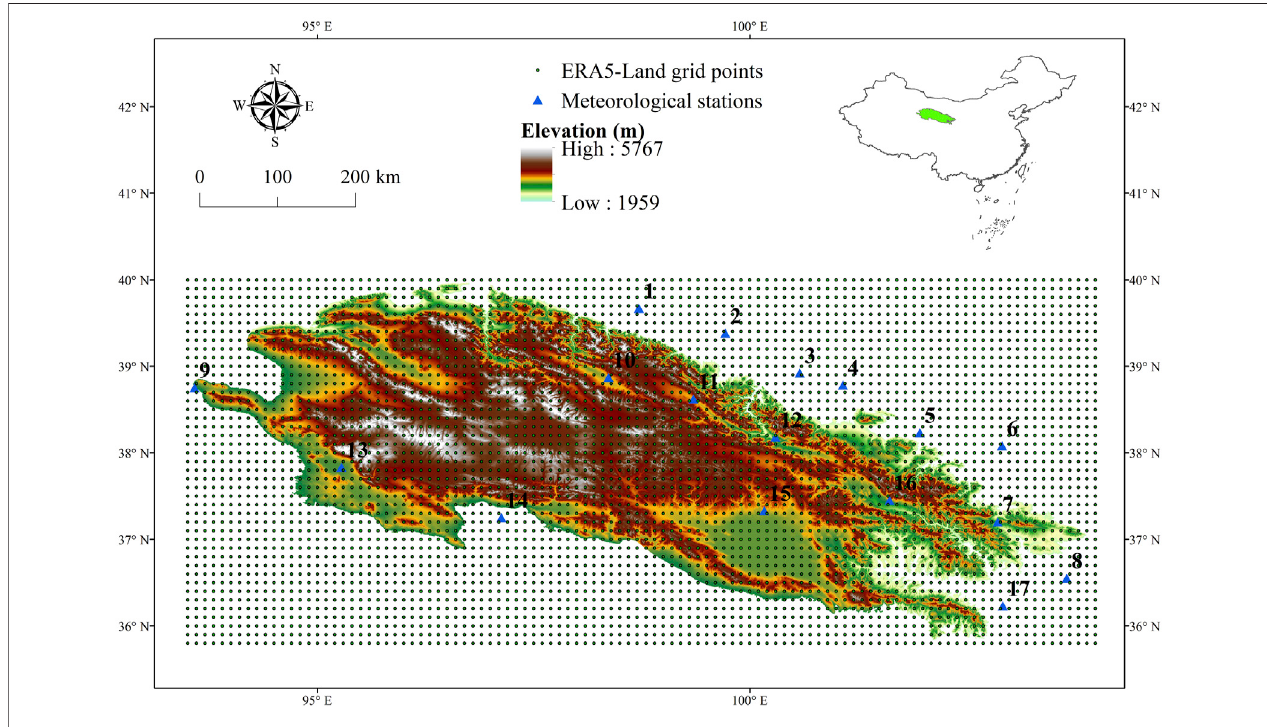
FIGURE 1 | Spatial distribution of ERA5-Land grid points and meteorological stations over the QLM.